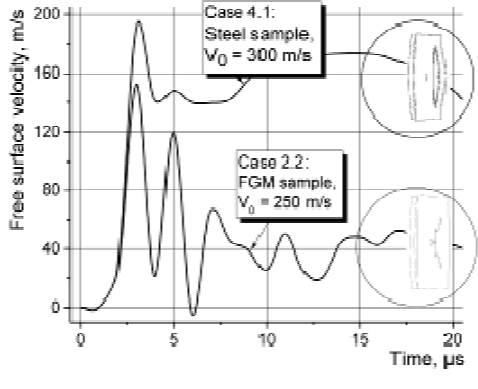
Fig. 7. Free surface profile for Case 4.1 and Case 2.2.